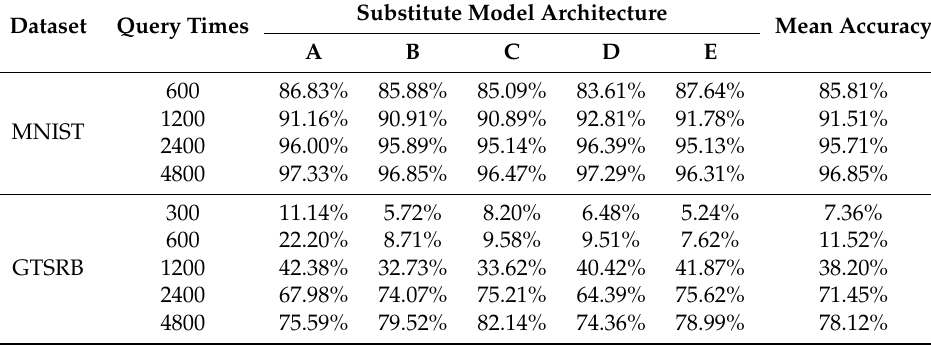
Table 2. Accuracy of the substitute models via ensemble training. Compared with Figure 4, we can find that our ensemble training method doesn’t decrease the accuracy of substitute models. Therefore, the ensemble attack is feasible through these models according to the analysis of the importance of the substitute models’